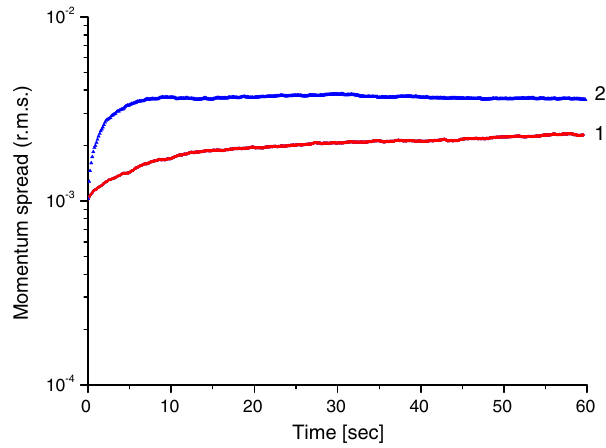
FIG. 6. BETACOOL simulations of beam loss rates in ELISA. 10 (cid:4) mm mrad corresponds to a lifetime (cid:5) ¼ 12 s (blue curve 1). Assuming a ring acceptance of A ¼ 50 (cid:4) mm mrad the lifetime would be (cid:5) ¼ 24 s (red curve 2), i.e., double the observed value.